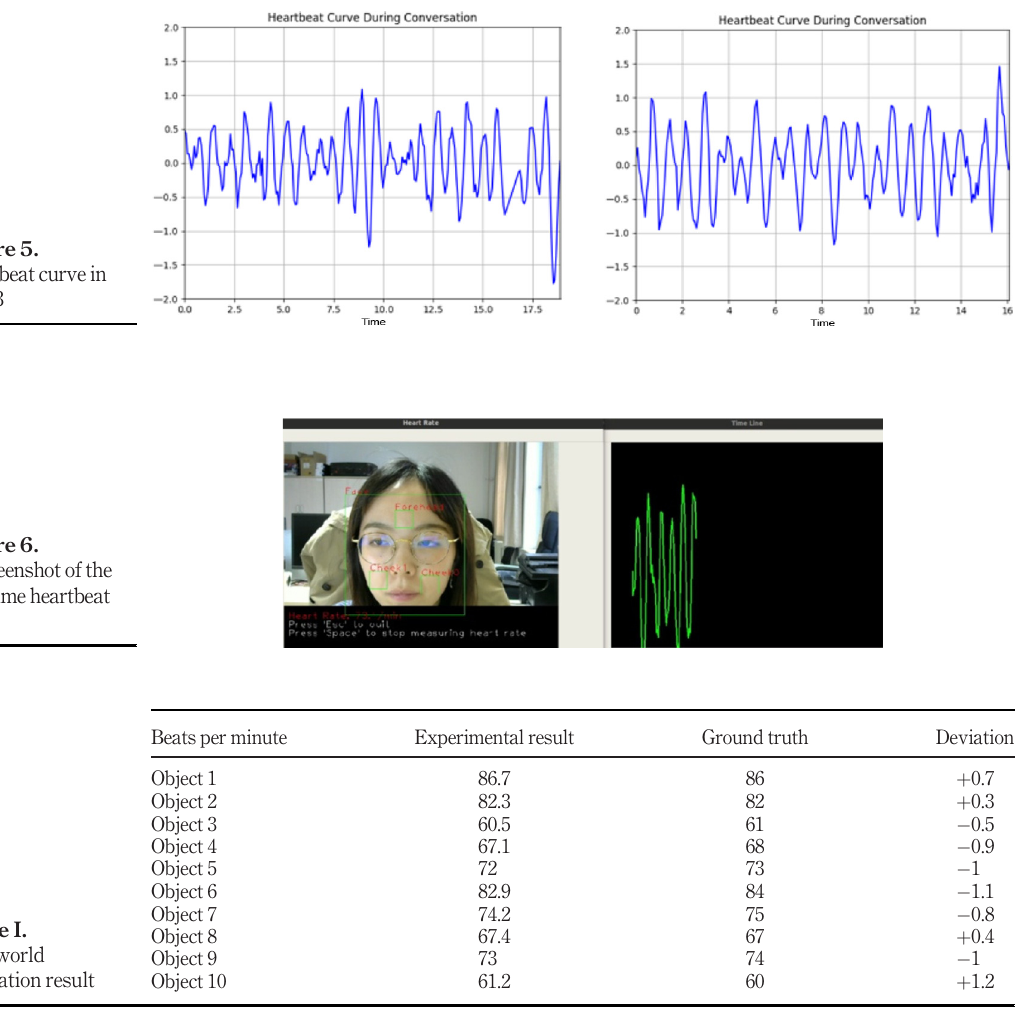
Table I. Real-world evaluation result